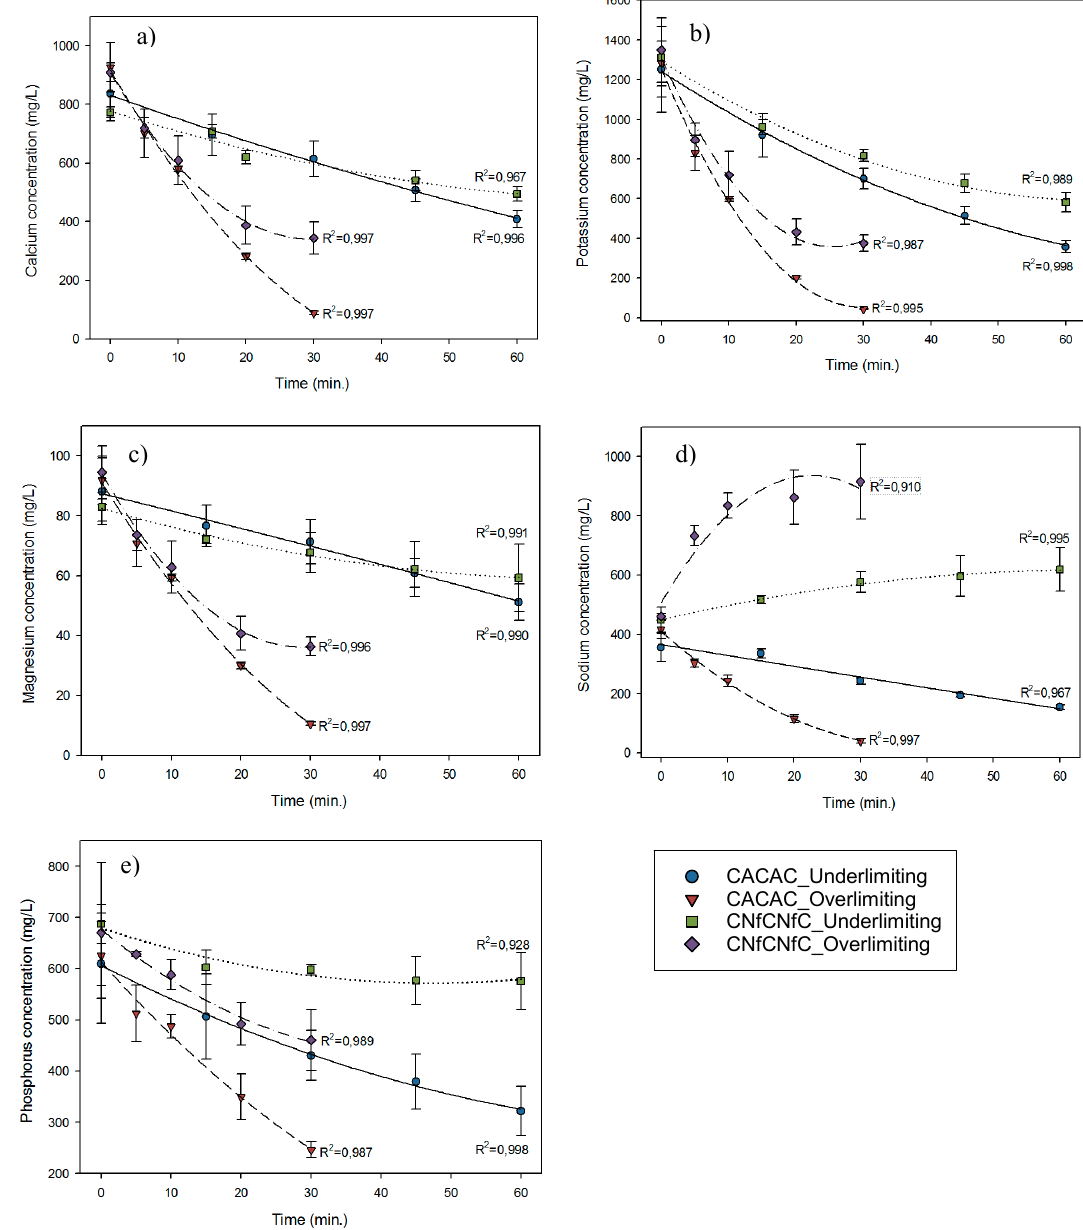
Figure 8. Ion concentration in whey compartment during ED treatments: a ) calcium, b ) potassium, c ) magnesium, d ) sodium, and e ) phosphorous.